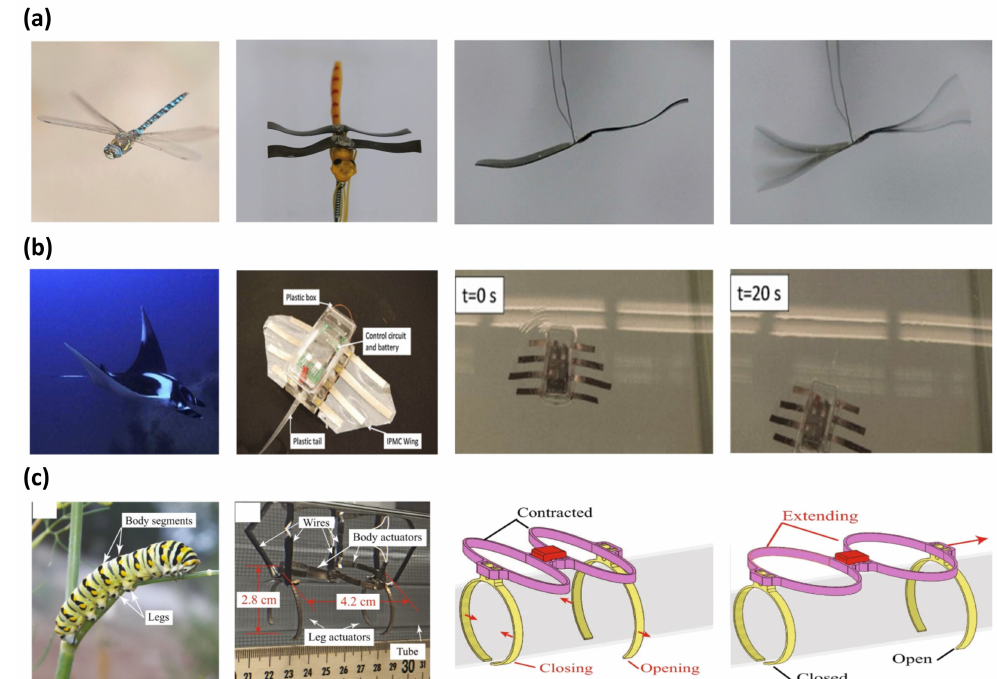
Figure 9. Demonstration of biomimetic IPMC actuator inspired by ( a ) dragonfly, adapted from Ma et al. [30] with permission from Wiley-VCH Verlag GmbH, Copyright (2019). ( b ) Manta ray, adapted from Chen et al. [145] with permission from Elsevier, Copyright (2011), and ( c ) Caterpillar. Adapted from Carrico et al. [149] with permission from Nature Portfolio, Copyright